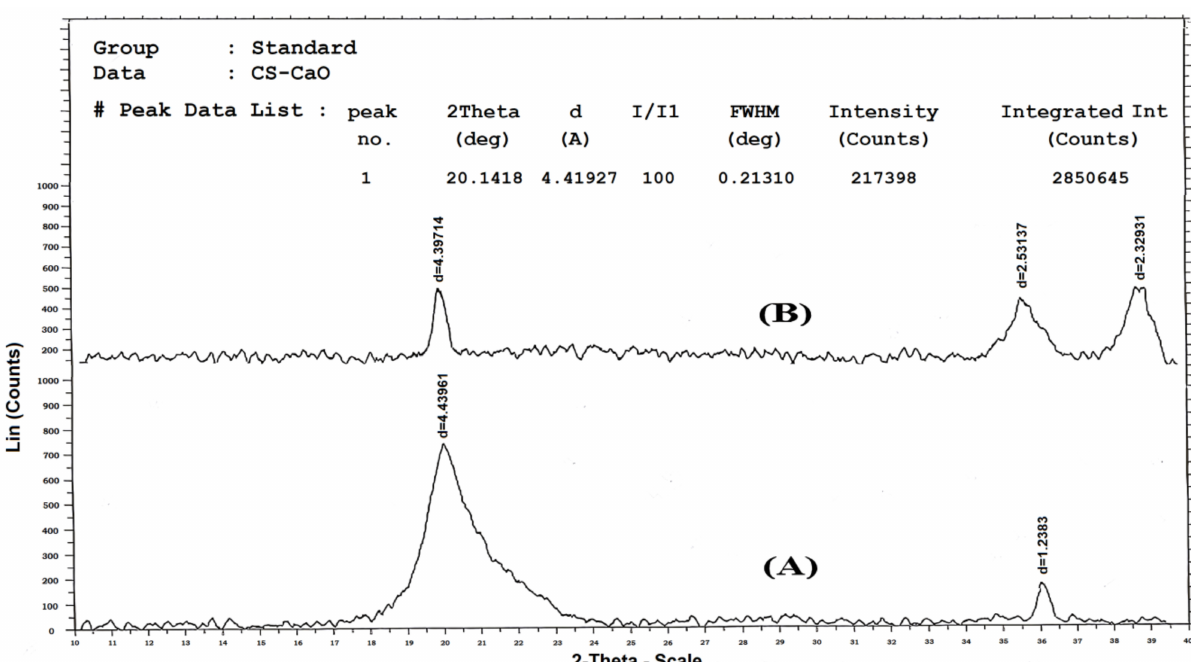
Figure 3. XRD of chitosan ( A ) and the chitosan–CaO nanocomposite (15 wt%) ( B ).